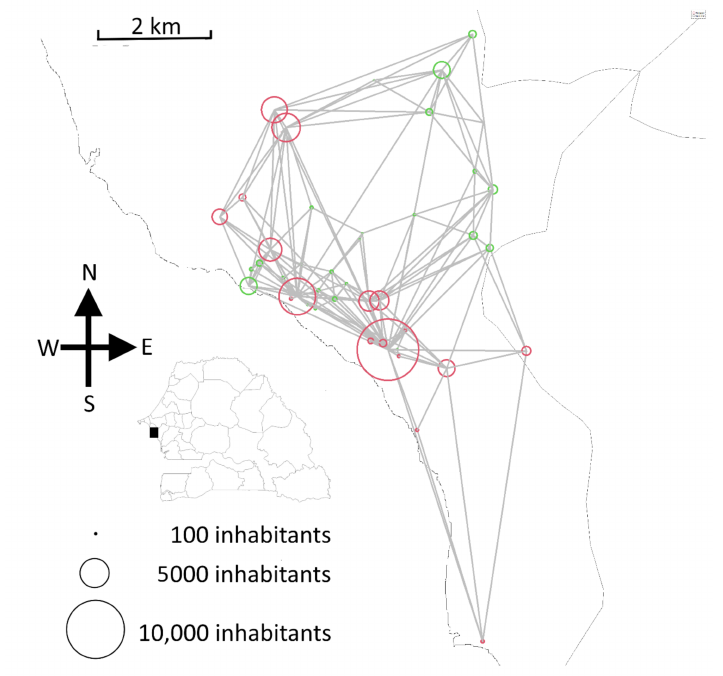
Figure A3. Mbour zone, Senegal, 2008–2012. Geographical coordinates of the 45 villages circles. Red circles represent connectivity hotspots and gray lines represent main connections between